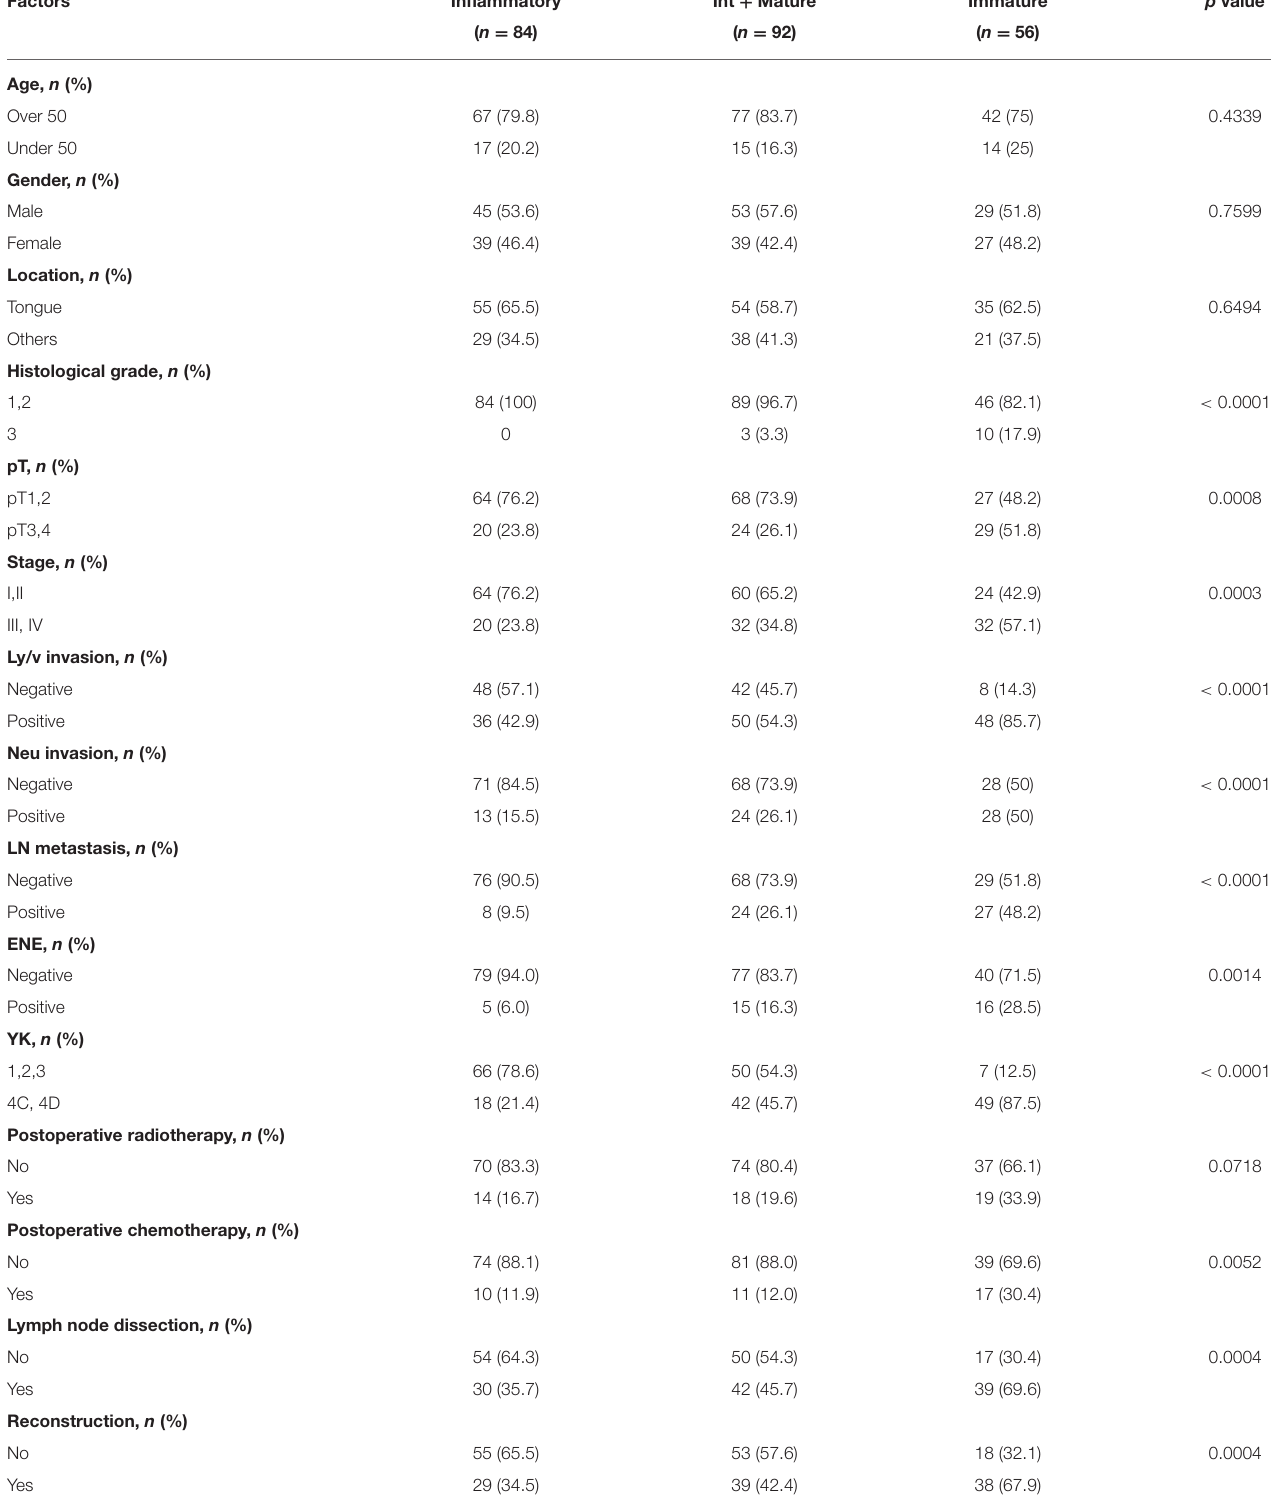
TABLE 1 | Correlations between the SP and clinicopathological factors.